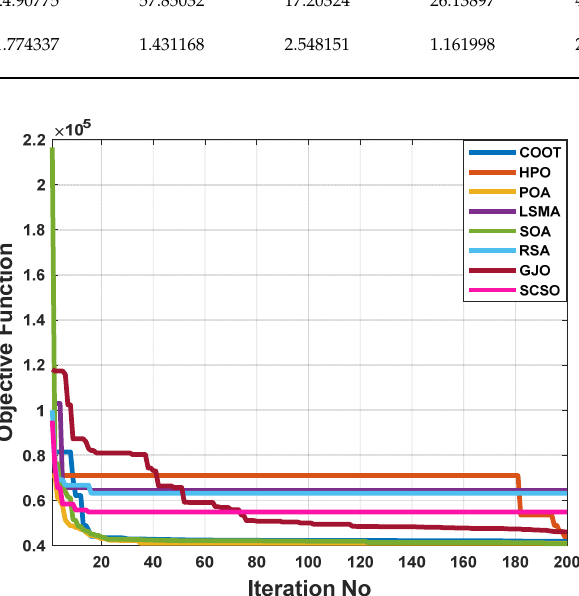
Figure 26. The convergence characteristics of POA and other compared algorithms for case 4 in a standard IEEE 57- bus test system.